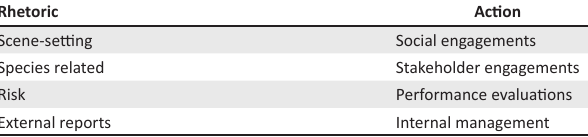
TABLE 3: Biodiversity theme classification. Rhetoric Action Scene-setting Social